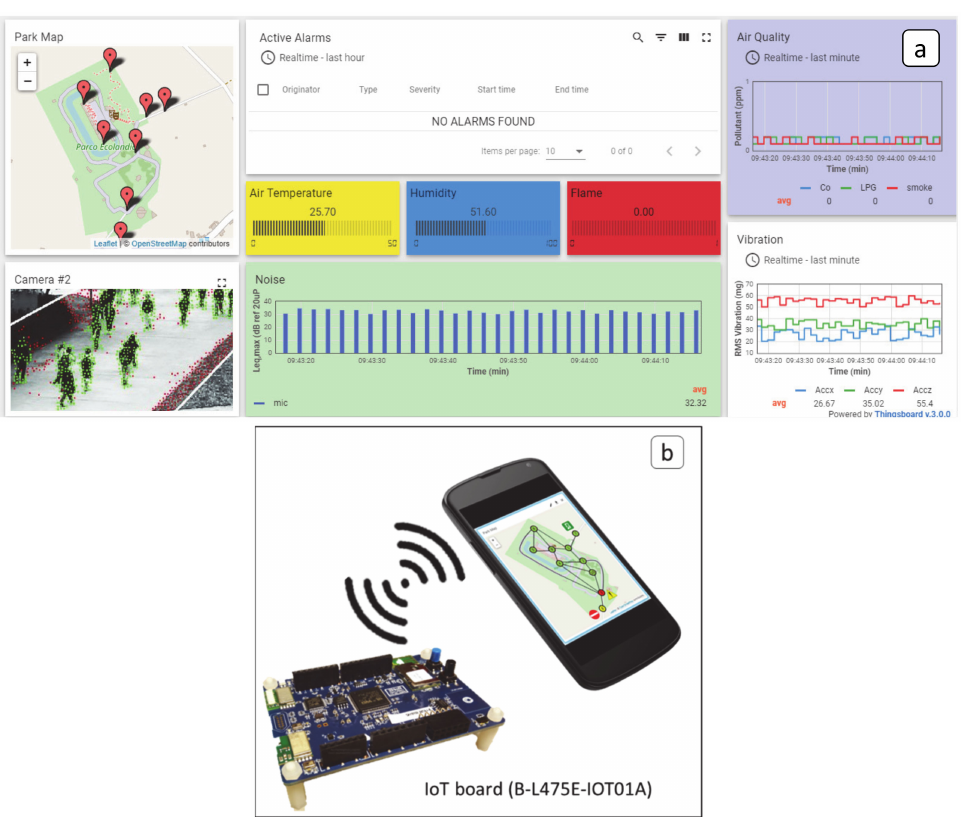
Figure 5. ( a ) IoT system dashboard; ( b ) Emergency plan provided by the NFC module-smartphone connection in the form of a smartphone compatible